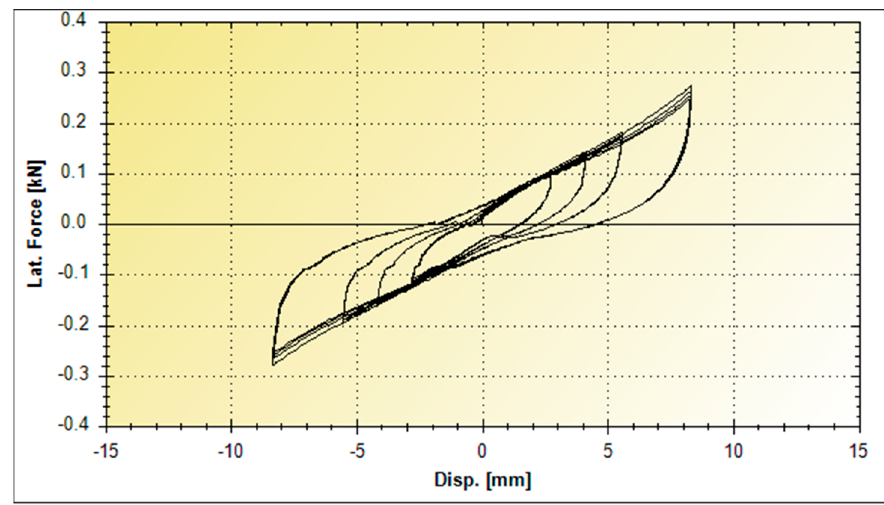
Figure 3. Force–displacement test curve graph. Table 1. Result data for force–displacement.